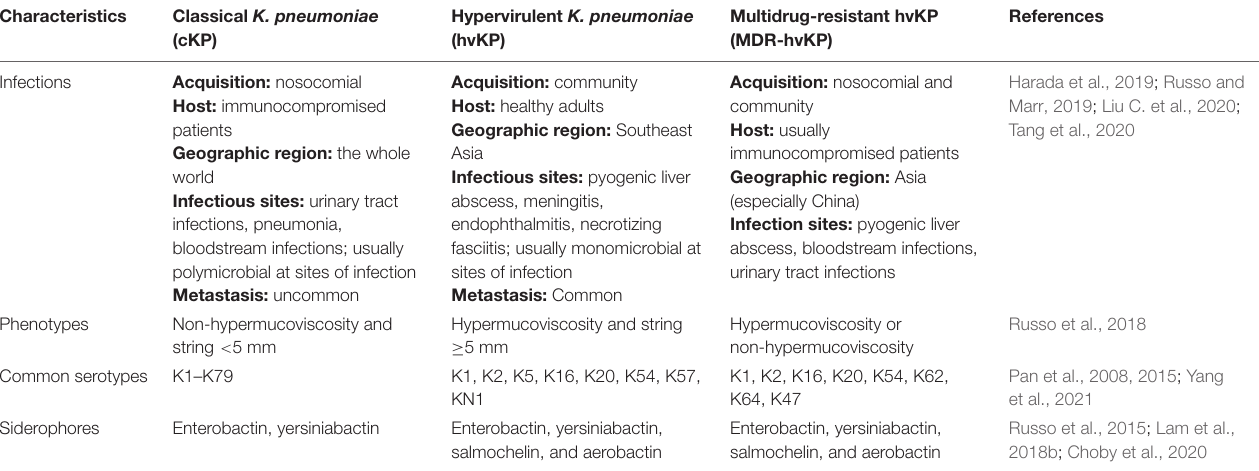
TABLE 1 | Main characteristic of cKP, hvKP, and MDR-hvKP.